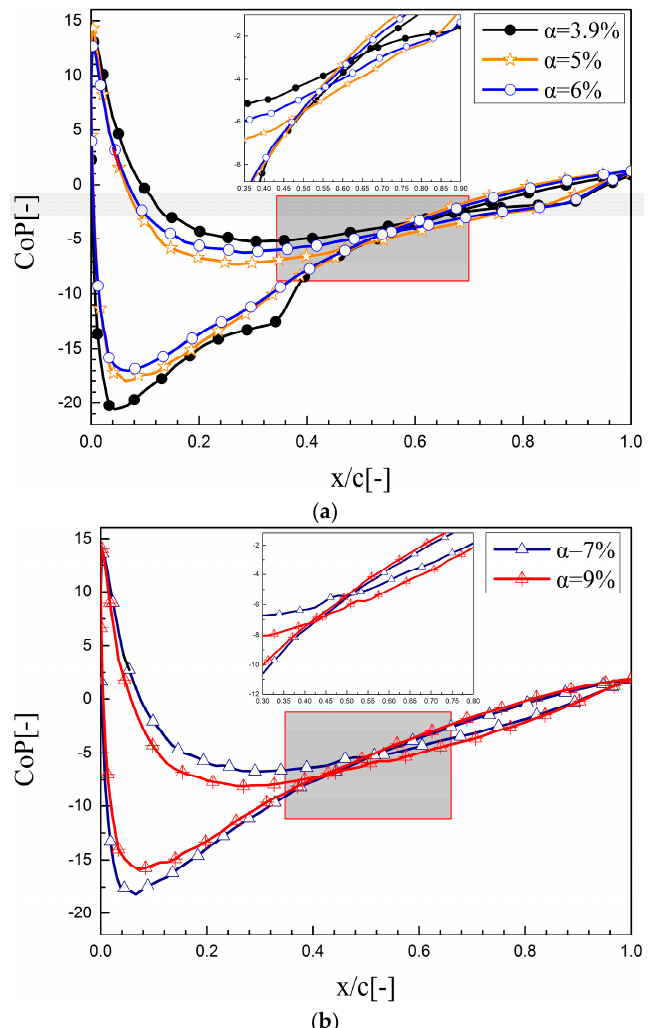
Figure 15. ( a ) Pressure coefficient distribution for blade 1 surface at azimuth angle of 270°; and, ( b ) pressure coefficient distribution for blade 1 surface at azimuth angle 280°.